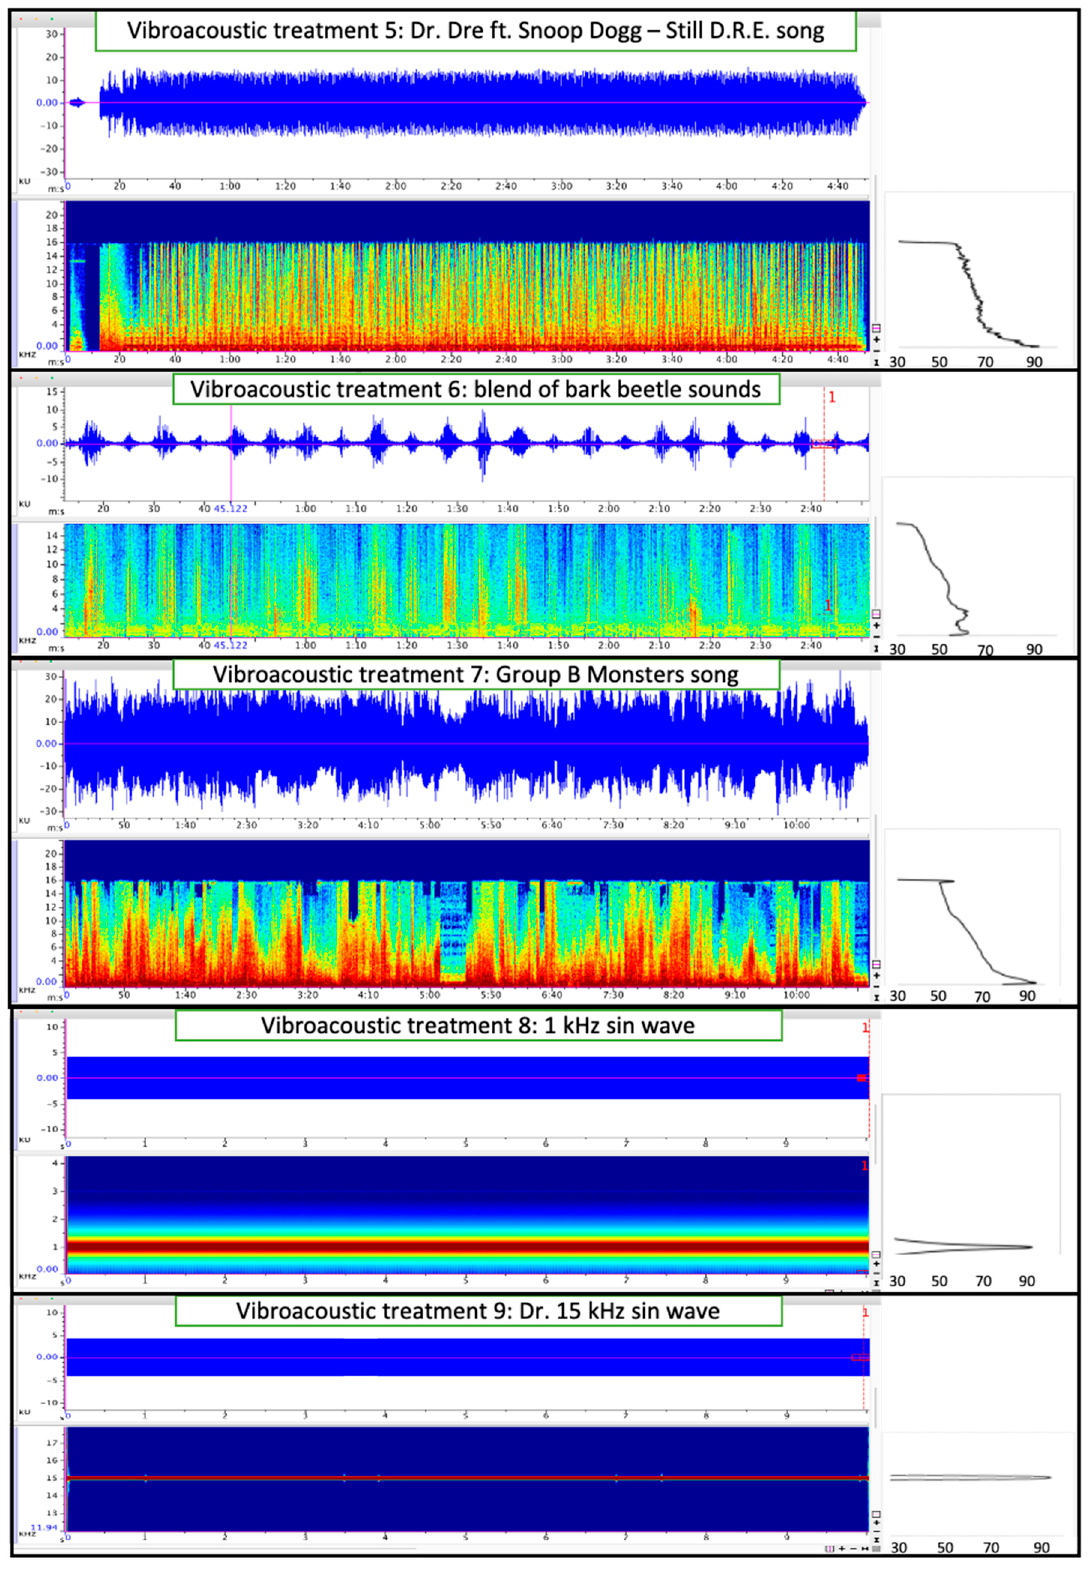
Figure 6. Waveform (top panel, amplitude over time in seconds), spectrograph (bottom panel, kHz over time in seconds), and mean spectrum (right panel, kHz over dB re 20 μ Pa) of vibroacoustic treatments (5 through 9) played into logs to test Ips confusus behavior. The x-axis is in seconds.